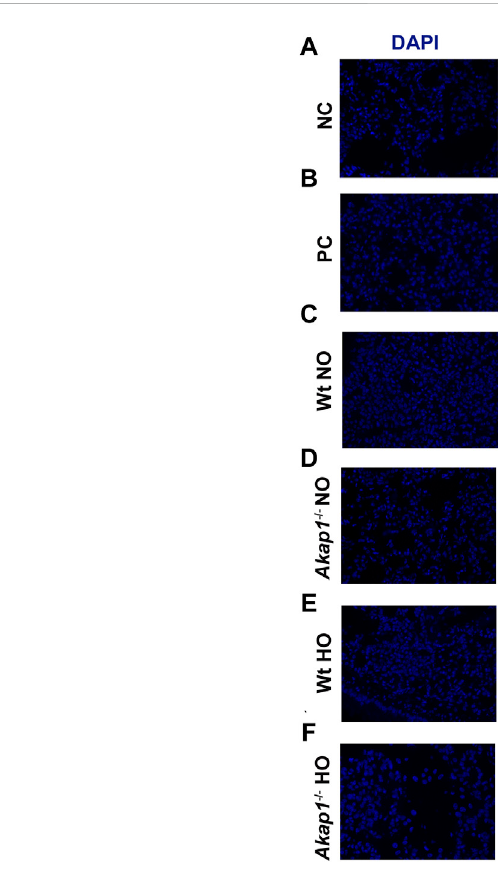
FIGURE 7 Increase in TUNEL positive cells in Akap1 − / − mice exposed to hyperoxia. (A) Representative images of negative control (NC) and (B) positive control (PC), respectively. (C,D) Representative images of Wt normoxia and Akap1 − / − normoxia lung sections stained with FITC and DAPI. (E,F) Representative images of Wt hyperoxia and Akap1 − / − hyperoxia lung sections stained with FITC and DAPI. Nuclei stained with DAPI (blue) and TUNEL positive cells stained with FITC (green). Magni fi cation: ×400, scale bar: 50 μ m. NO = normoxia and HO =